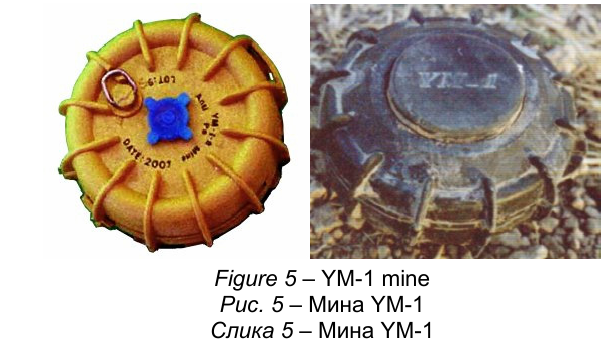
Figure 5 – YM-1 mine Рис . 5 – Мина YM-1 Слика 5 – Мина